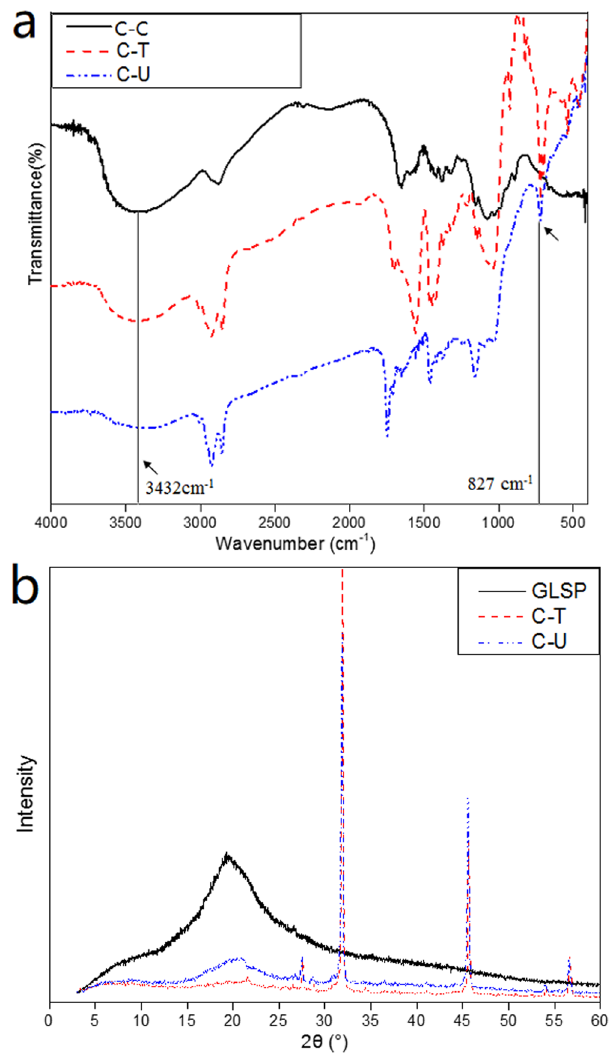
Figure 3. FTIR spectra of C-C, C-T and C-U ( a ); XRD analysis of GLSP, C-T and C-U ( b ).